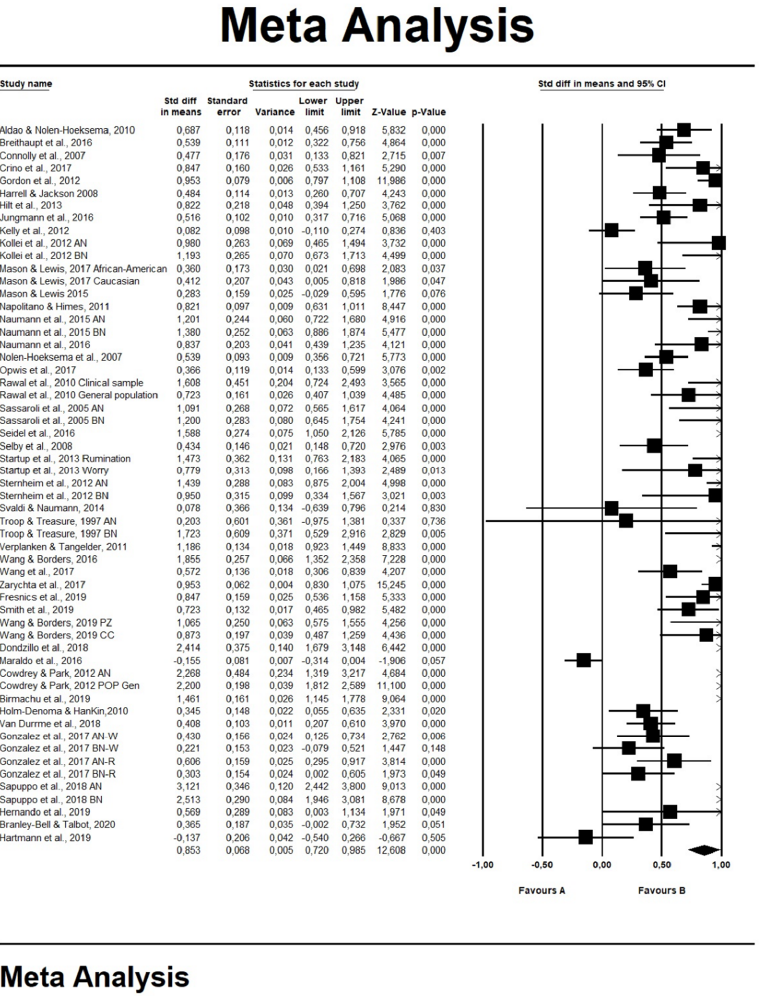
Figure 2. Forest plots for repetitive thinking and eating behavior. Box indicates effect sizes (ESs), while error bars represent 95% confidence intervals (CIs). The rumble represents the average ES. Note: Favors A = negative association between repetitive thinking and eating disorders. Favors B = positive association between repetitive thinking and eating disorders. The rumble represents the average ES. Moderator Analyses: Subtypes of ED Symptoms, Presence vs. Absence of Diagnosis of EDs, Worry–Rumination and Age